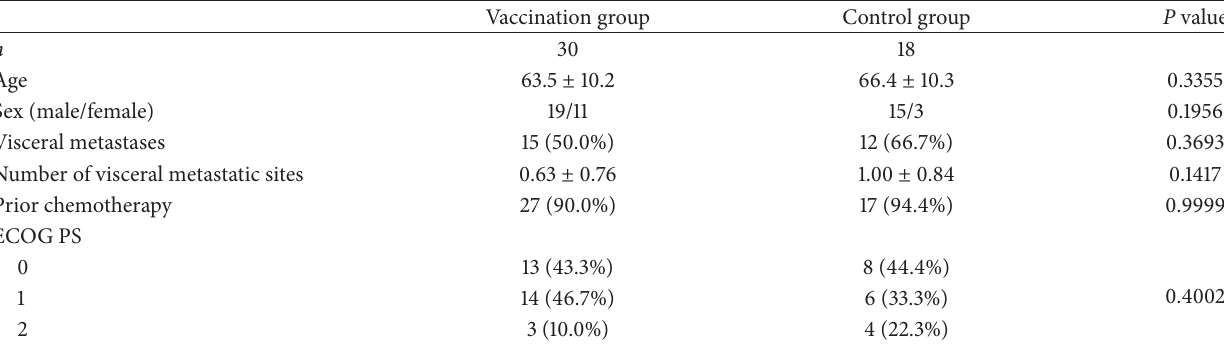
Table 4: Clinical characteristics of vaccination group and control group.